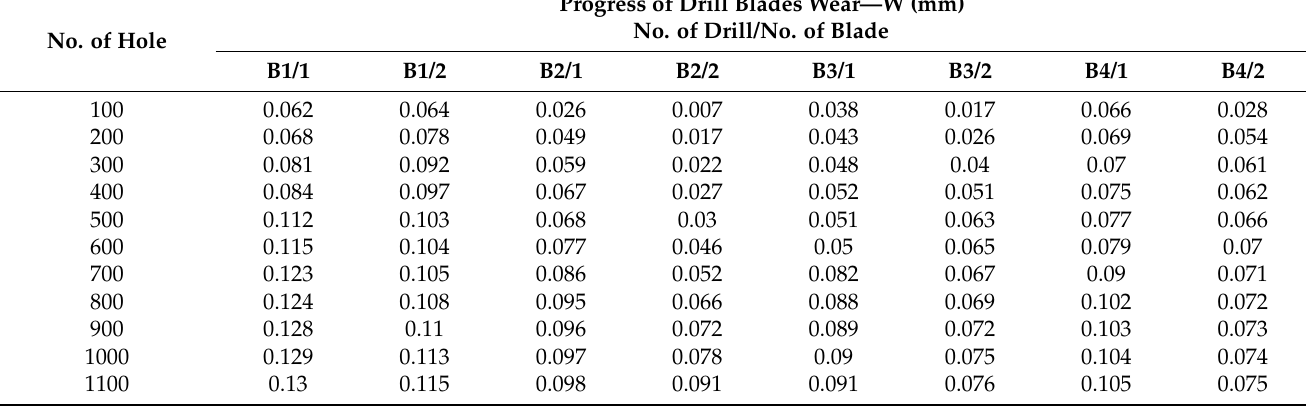
Table 4. The values of outer corner wear (W) measured while monitoring the condition of drill bits from Group C (experimental group containing four two-blade tools that were coated with “TiAlN/a-C:N”). The table contains the data shown in Figure